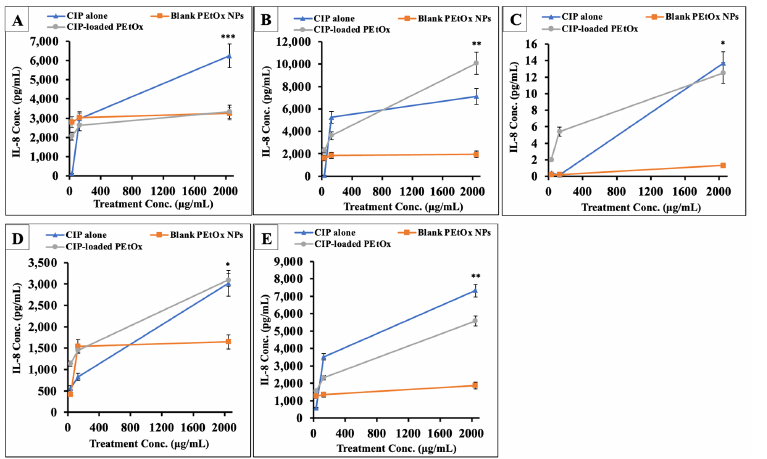
Figure 7. Proinflammatory effects of CIP alone, blank PEtOx NPs, and CIP-loaded PEtOx NPs on ( A ) NHBE cells, ( B ) DHBEs, ( C ) CFBE41o-cell line, ( D ) HCs macrophages, and ( E ) CF-like macro- phages. The IL-8 secretion levels were normalized with the number of cells by dividing the % cell viability estimated by the LDH assay. Results expressed as the mean ± SD ( n = 3) and p > 0.05 (*), p < 0.05 (**), p < 0.001 (***).